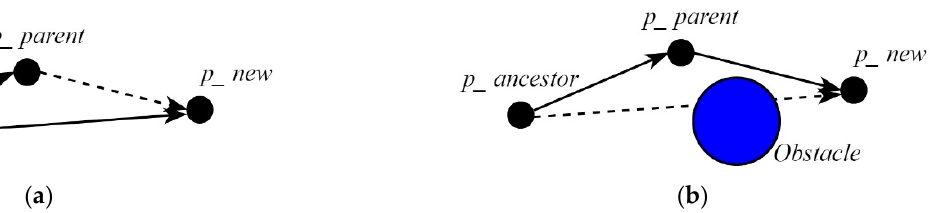
Figure 7. The pitch angle and projection of the angle between the vector ( p _ parent , p _ new ) and the vector ( p _ ancestor , p _ parent ) on different planes: ( a ) projection on plane xoz; ( b ) projection on plane yoz; ( c ) projection on plane xoy; and ( d ) pitch angle.